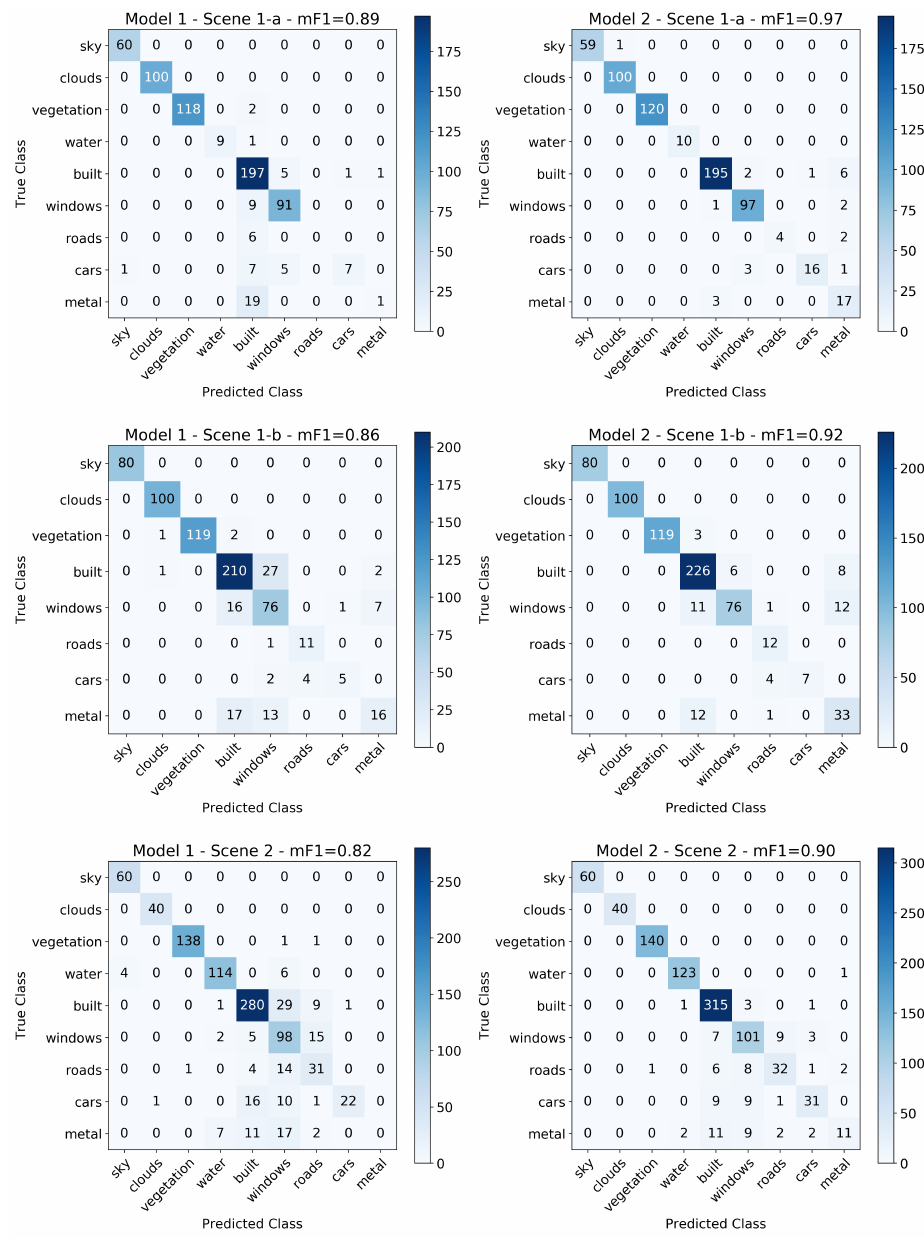
Figure A1. Confusion matrices used to derive the metrics in Table 1 for the classification of hand-labeled pixel spectra using Model 1 ( left ) and Model 2 ( right ) trained and tested on each scene